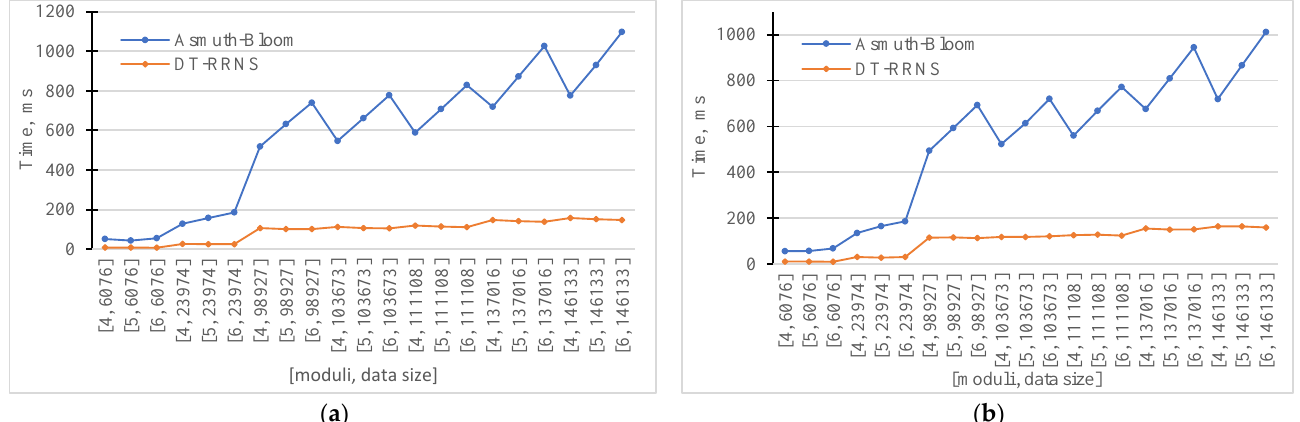
Figure 7. Encoding time and obtained redundancy for Asmuth-Bloom and DT-RRNS ( a ) Encoding time. ( b ) Decoding time.